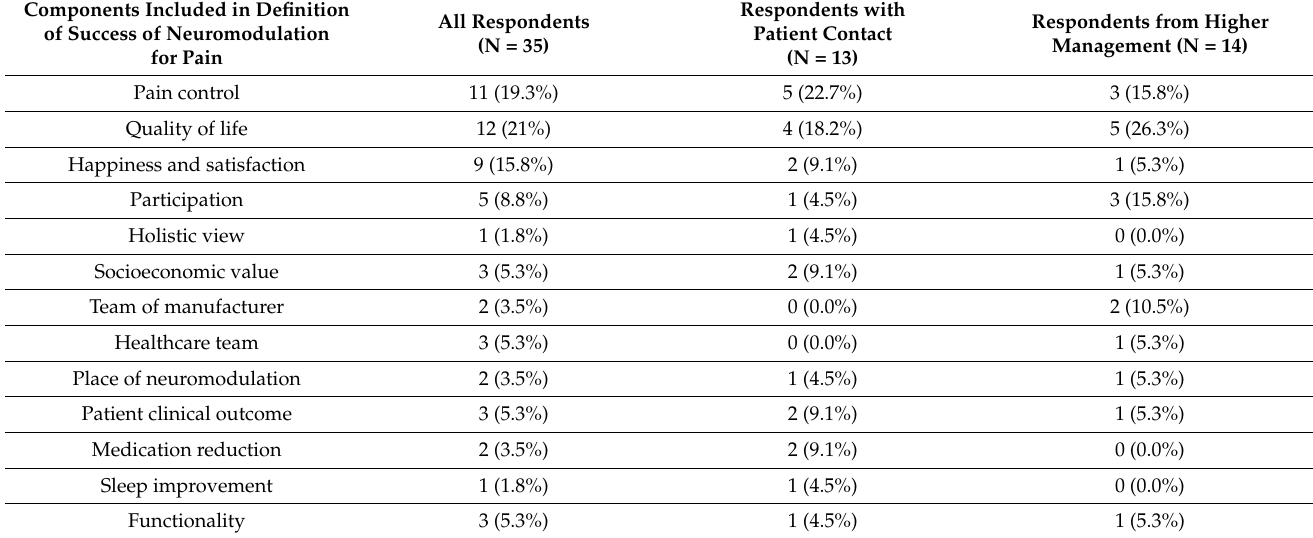
Table 3. Extracted components from the definition of success for neuromodulation for pain according to representatives of neuromodulation device manufacturers. Separate results are provided for representatives with direct patient contact and representatives from higher management.